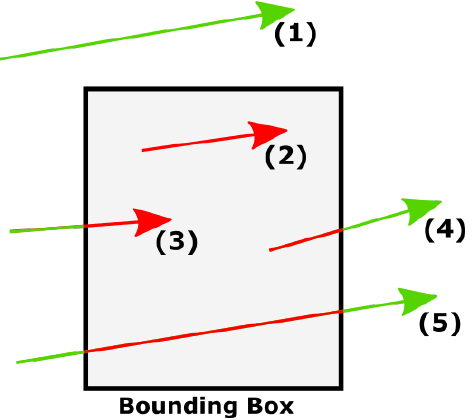
Figure 2. Intersecting ray and bounding box leads to five cases that need to be handled. Valid parts of the ray are in green, invalid ones in red. (1) No intersection with ray. (2) Ray is inside. (3) Ray starts outside but ends inside. (4) Ray starts inside, but ends outside. (5) Ray starts and ends outside, thereby traversing the bounding